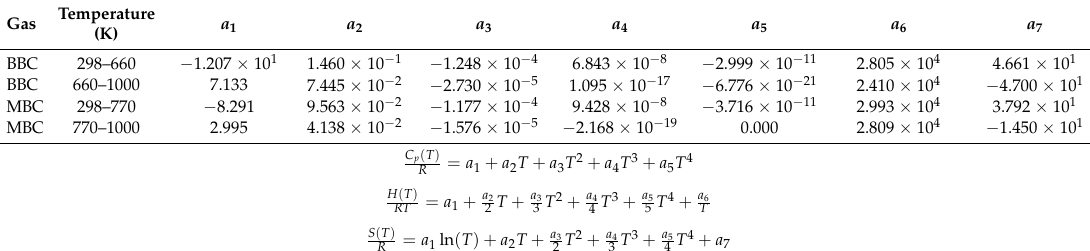
Table 2. Thermodynamic data for BBC(g) and mono(benzene)chromium (MBC(g)); T is the temperature, R the universal gas phase constant, H the enthalpy, S the entropy and C p the specific heat.